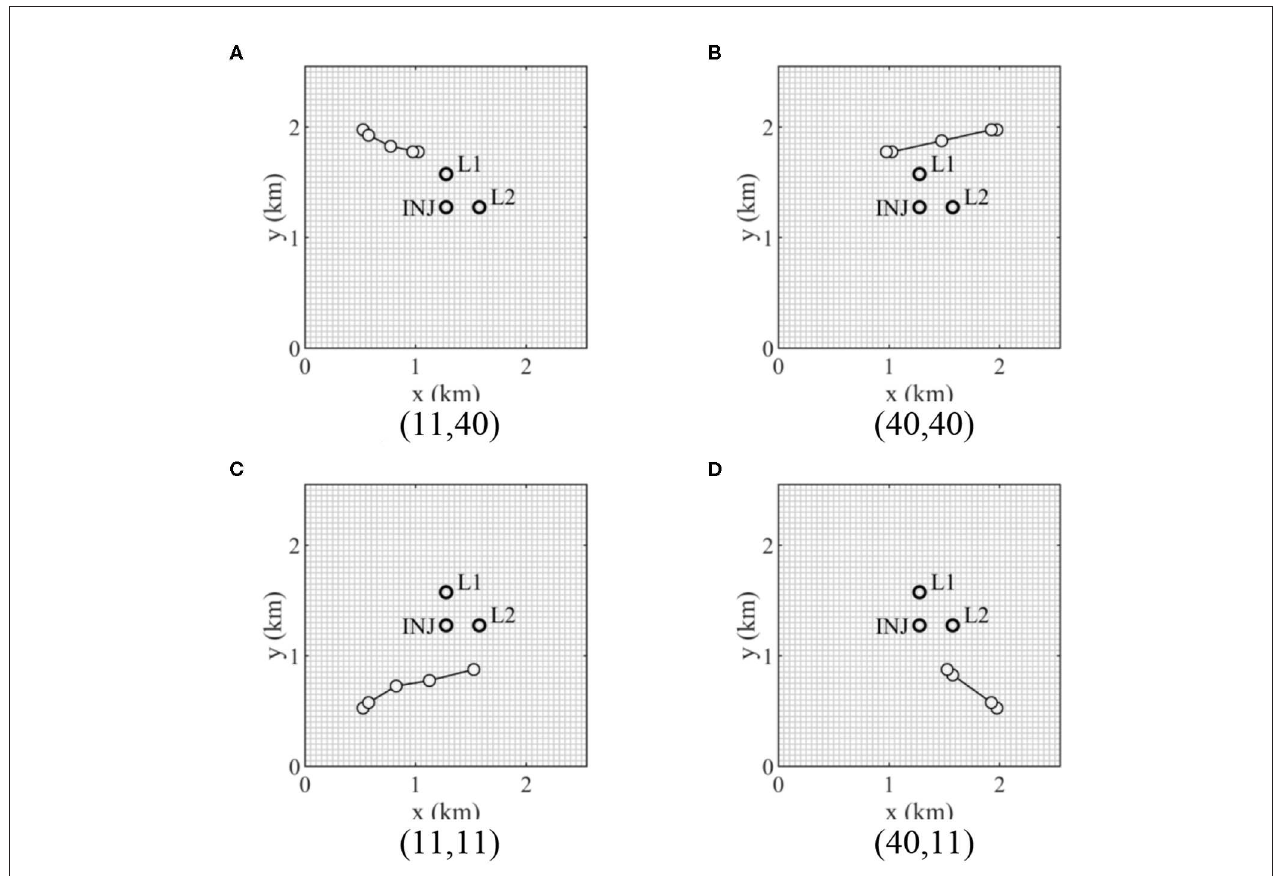
FIGURE 5 | Iteration steps of well placement of a brine extraction well using HSG for four initial solutions ( I and J indices). INJ and L1 and L2 represent the CO 2 injector and two leaky abandoned wells, respectively. (A) 1st initial solution (11,40). (B) 2nd initial solution (40,40). (C) 3rd initial solution (11,11). (D) 4th initial solution (40,11).